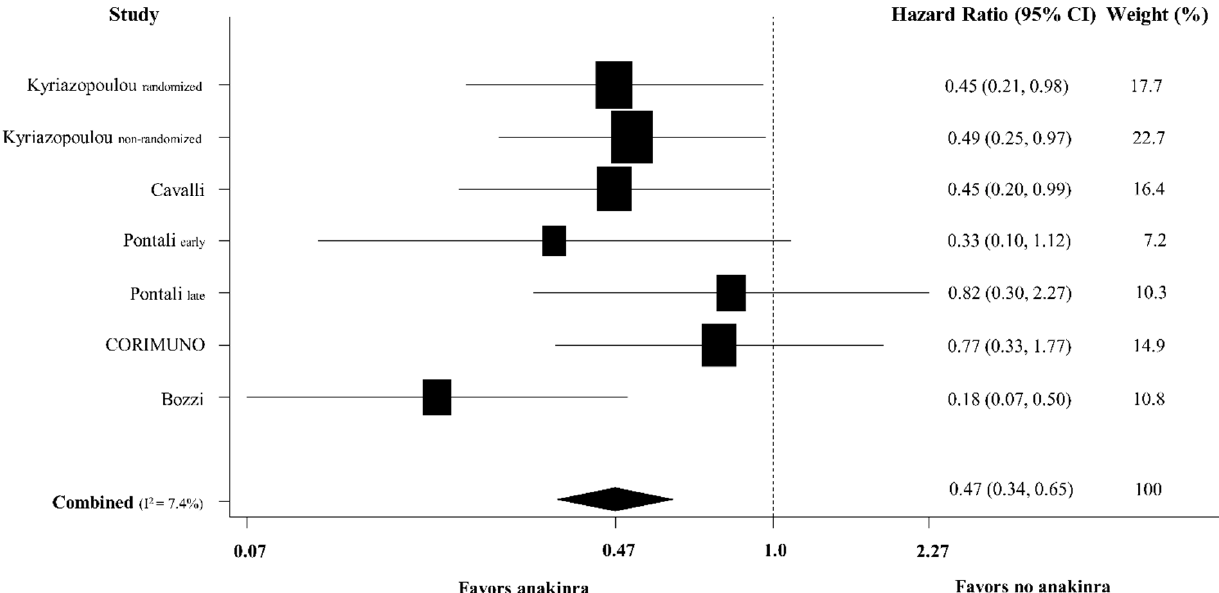
Figure 1. Forest plot of adjusted hazard ratios for death for patients treated with anakinra versus those who did not receive anakinra among hospitalized patients with COVID-19.